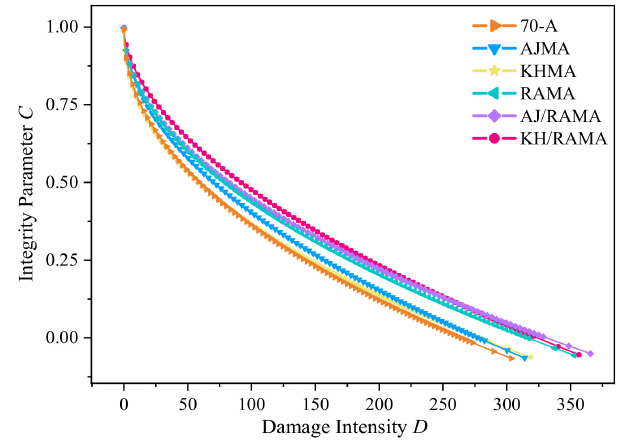
Figure 10. Damage characteristic curve.